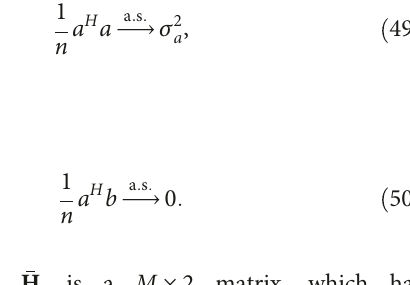
Figure 9: The XPD e ff ect comparison.